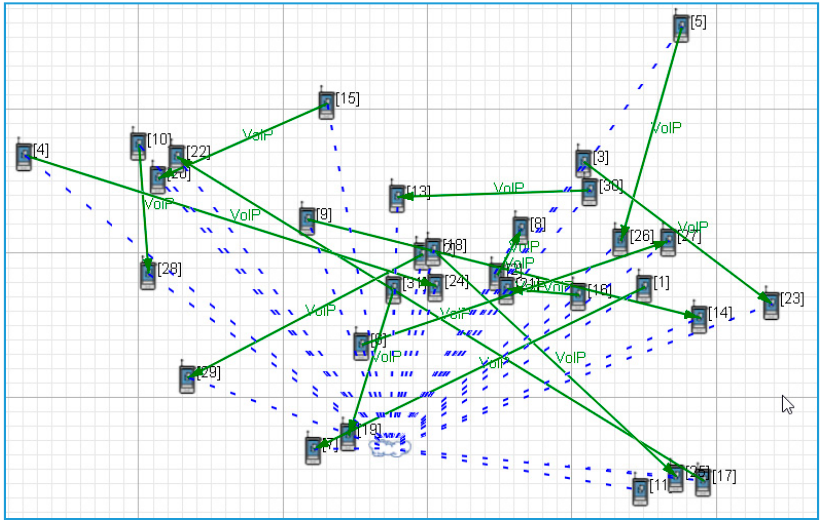
Figure 7. First responders with random waypoint mobility (captured during simulation).